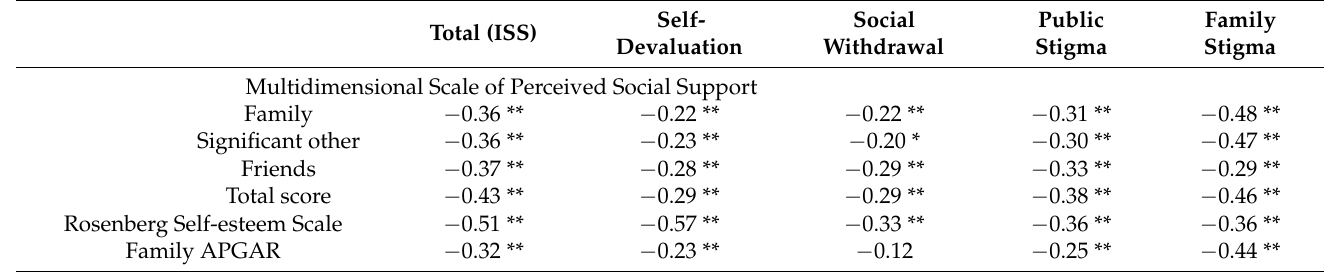
Table 7. Correlation of the ISS with the Multidimensional Scale of Perceived Social Support, the Rosenberg Self-esteem Scale, and the Family APGAR ( N = 254).